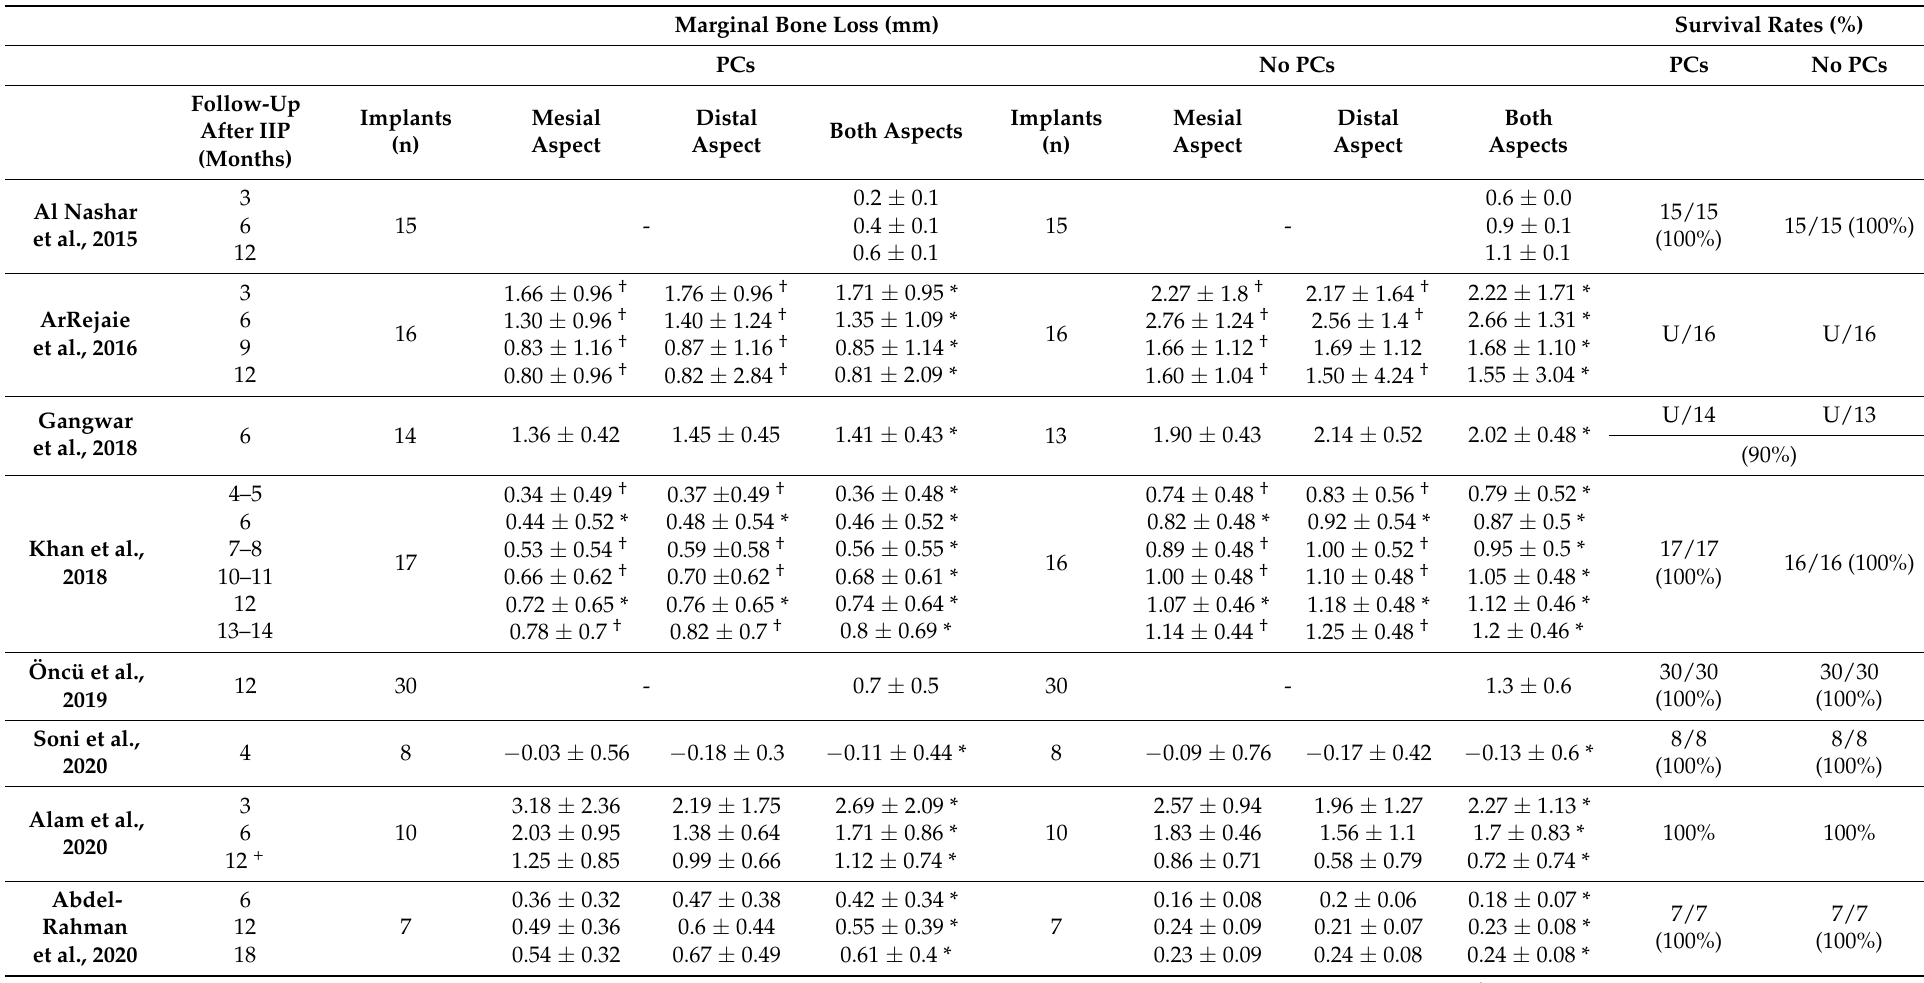
Table 4. Marginal bone loss (MBL) during the postoperative period (mean ± SD) and implants survival rates